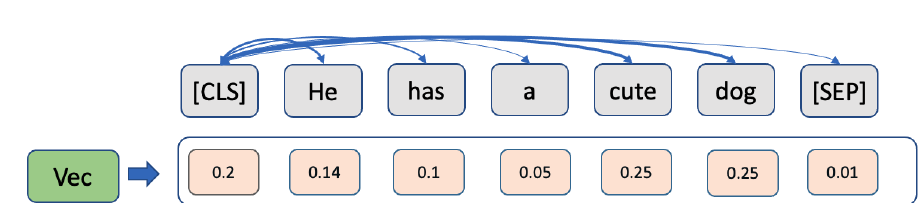
Figure 3. The attention vector of the [CLS] token captures the linguistic information by the attention values. The thickness of the arrows represents the attention weights.